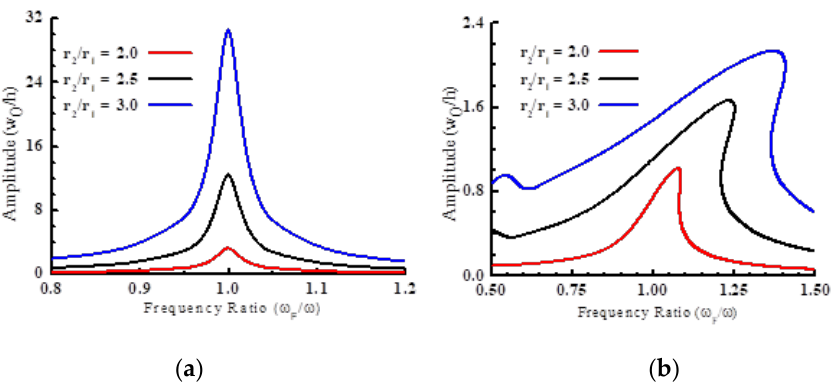
Figure 12. Effect of annularity ratio ( r 2 /r 1 ) on the ( a ) linear and ( b ) nonlinear, forced vibration re- sponse curves, for laminated annular sector plate ((0°/90°), b 1 /h = 100, ϕ = 60°, SSSS, f 0 = 30 Pa, b 1 = 1m, ζ = 0.01).